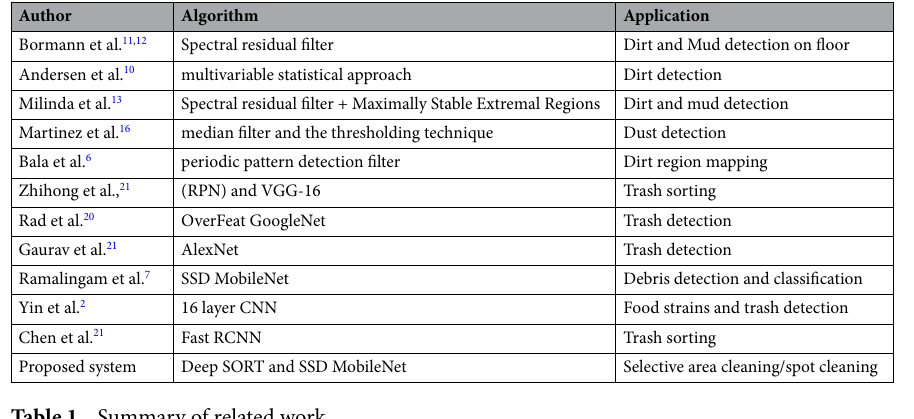
Table 1. Summary of related